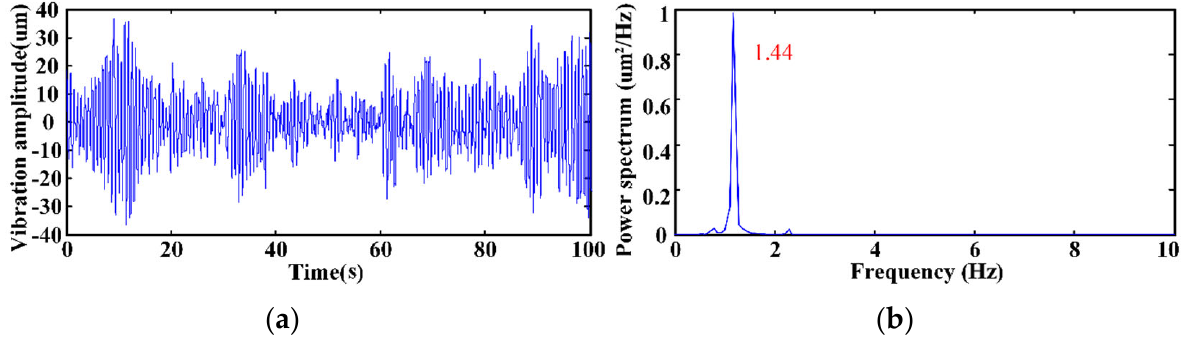
Figure 7. Time history signals and power spectra of B8 measuring point under condition 2. ( a ) Time history signals; ( b ) Normalized power spectra.